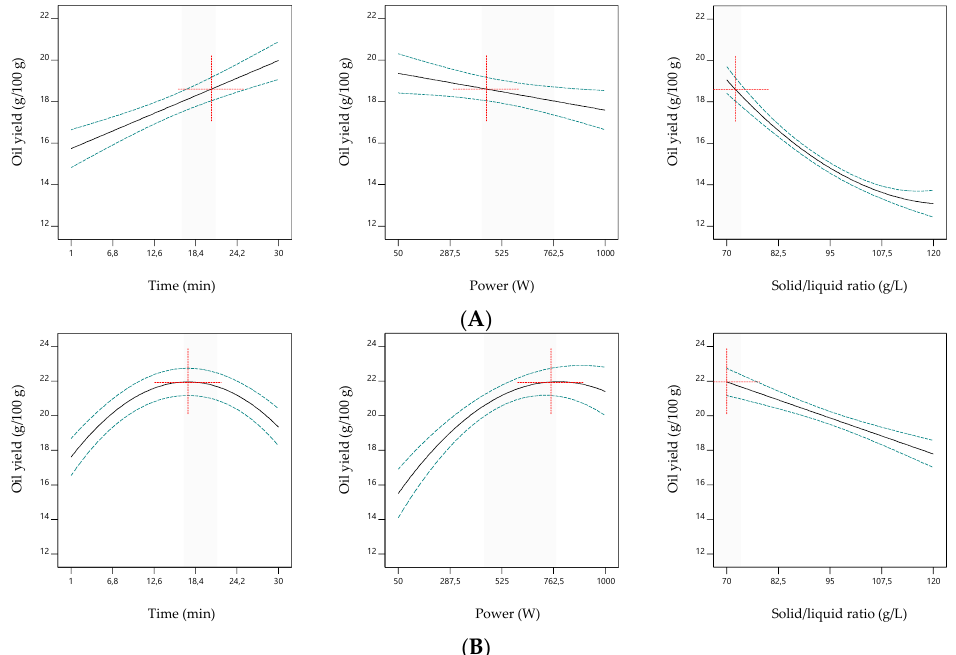
Figure 4. 2D response graphs for the effects of the independent variables on the oil yield obtained from the fish by-products S1 ( A ) and S2 ( B ). For each graph, the excluded variables were fixed at their optimal value.